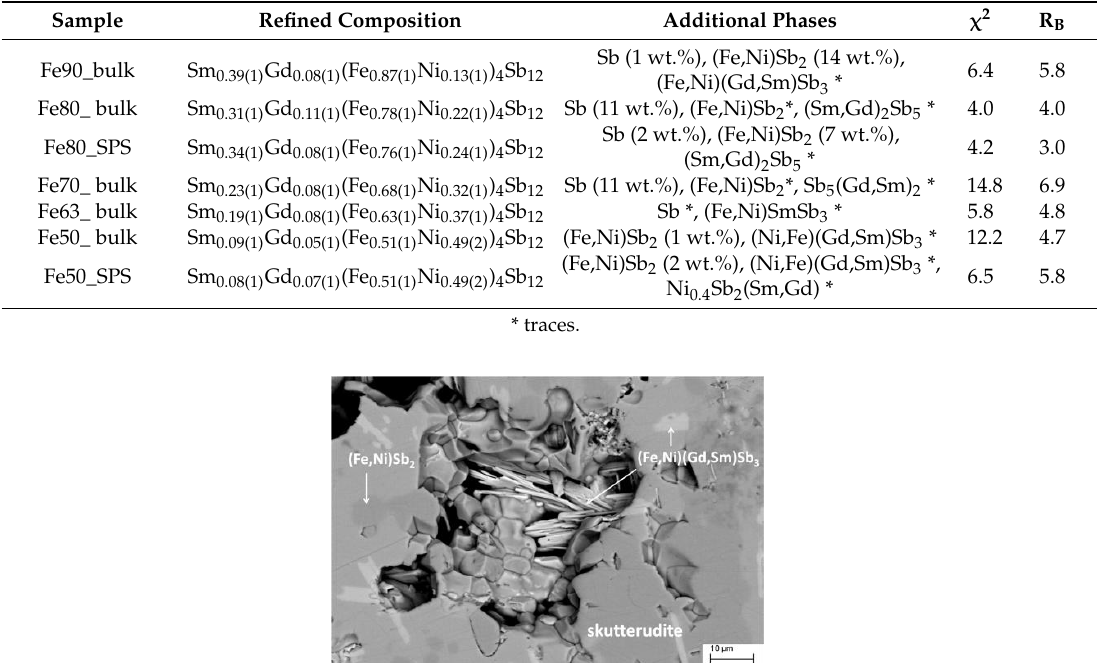
Table 1. The refined compositions, list of additional phases, and agreement factors of the Rietveld refinements ( χ 2 and skutterudite R B ).